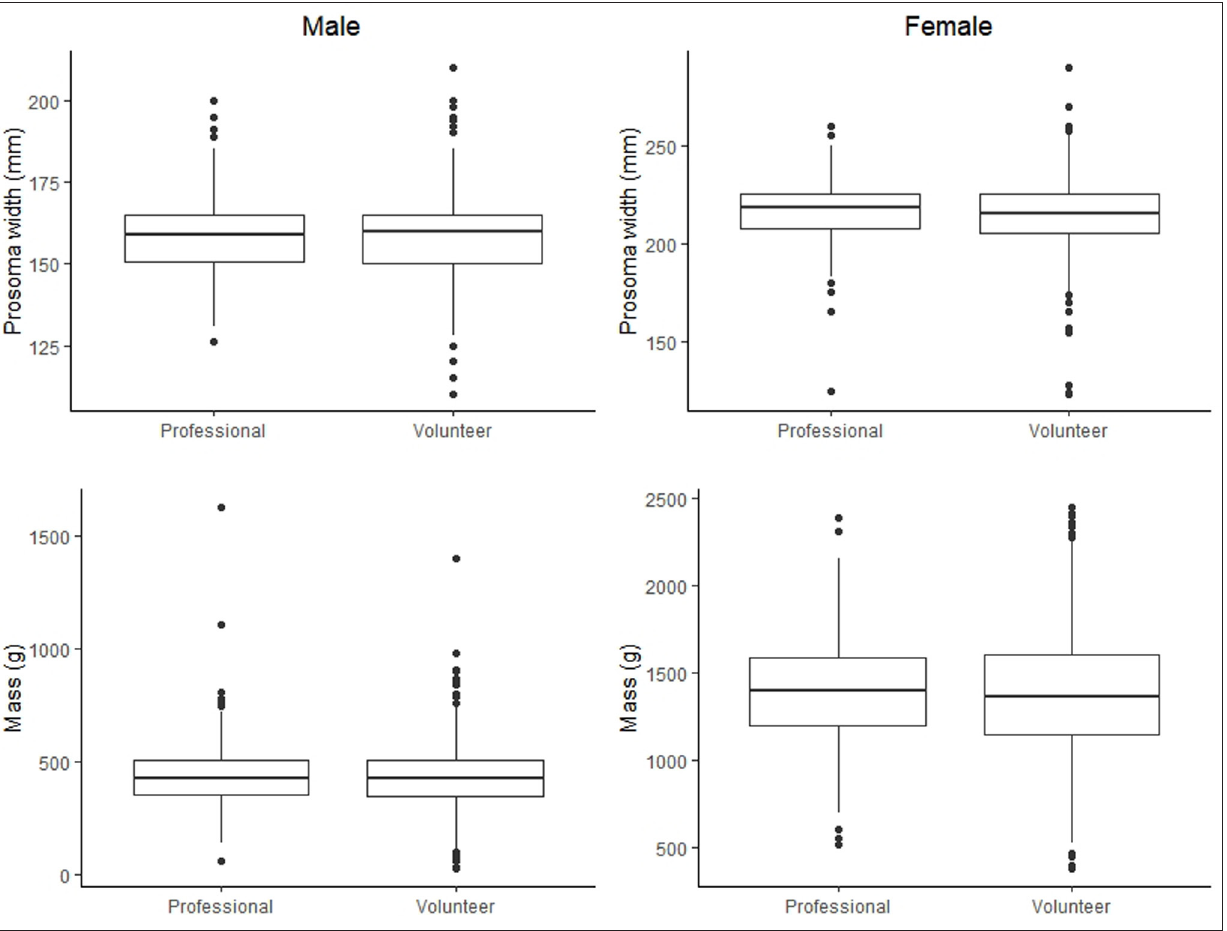
Figure 5 Box plot depicting mean prosoma width and mass for males and females, as collected by Florida Horseshoe Crab Watch professionals and volunteers. Median represented by center line; 25% quartiles within box; lines represent upper and lower 25% quartiles, and points represent outliers. Note that outliers are present in both professional- and volunteer-collected